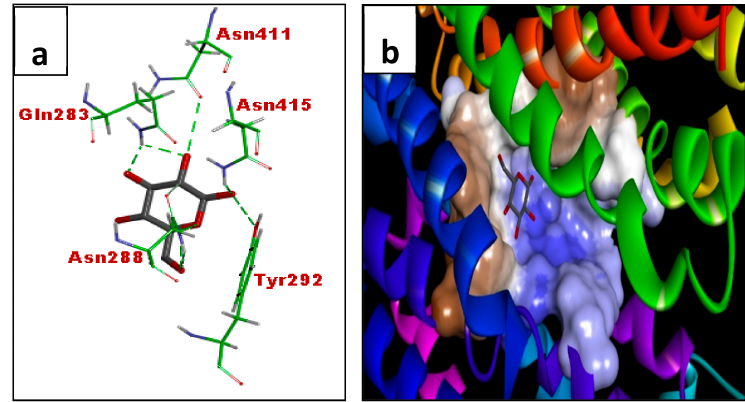
Figure 12. Binding interactions of glucose ( a ) with active site residues of GLUT1 (PDB ID: 5EQI). The compounds are coloured black while amino acids are green. Green and purple dashes depict hydrogen bond and hydrophobic bond, respectively. ( b ) Surface structure of glucose in active site of GLUT1. Blue and brown colours indicate polar and hydrophobic regions, respectively.